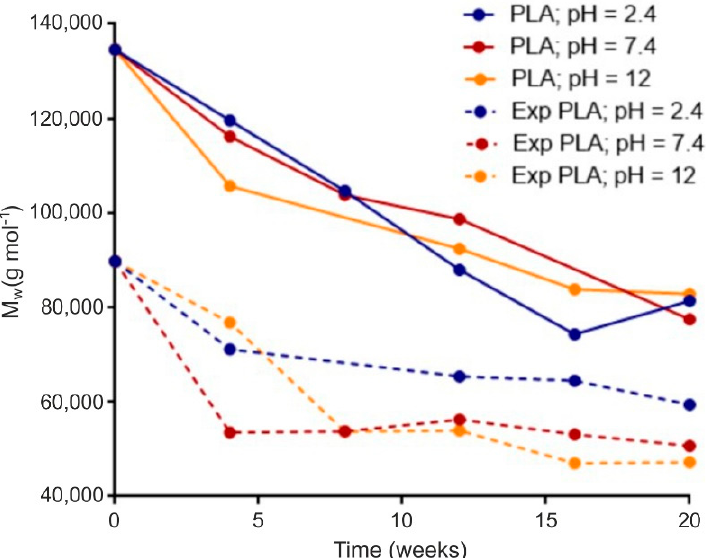
Figure 3. Molecular weight evolution for materials of PLA and expanded PLA in various phosphate buffer during abiotic hydrolysis at 37 °C.